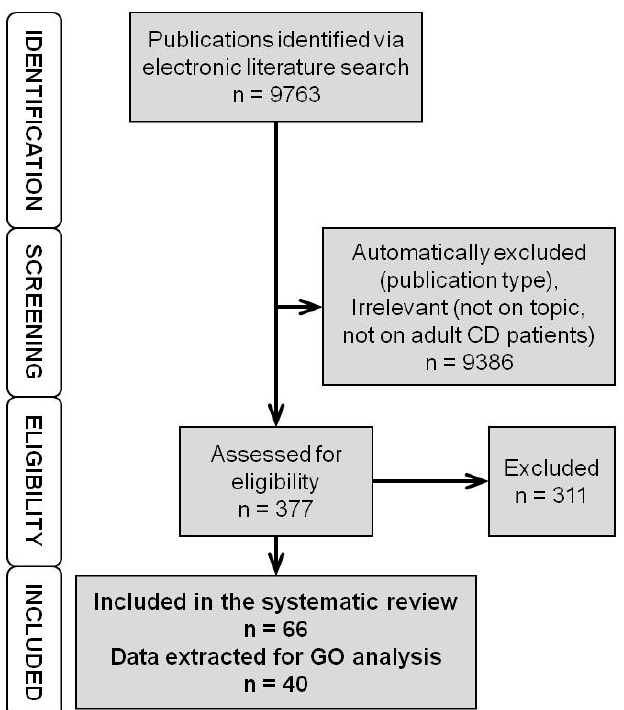
Figure 1. Flowchart of the literature search and selection. First, we identified the publications via electronic literature search. Then, using automatic screening, we excluded publication types not reporting new measurements / data and with manual screening irrelevant studies. The remaining publications were assessed for eligibility. Those reporting suitable (quantifiable) data on genomic or expression markers of anti-TNF response measured prior to therapy start were included in the systematic review. (TNF – Tumour Necrosis Factor, CD – Crohn’s Disease, GO – Gene Ontology)